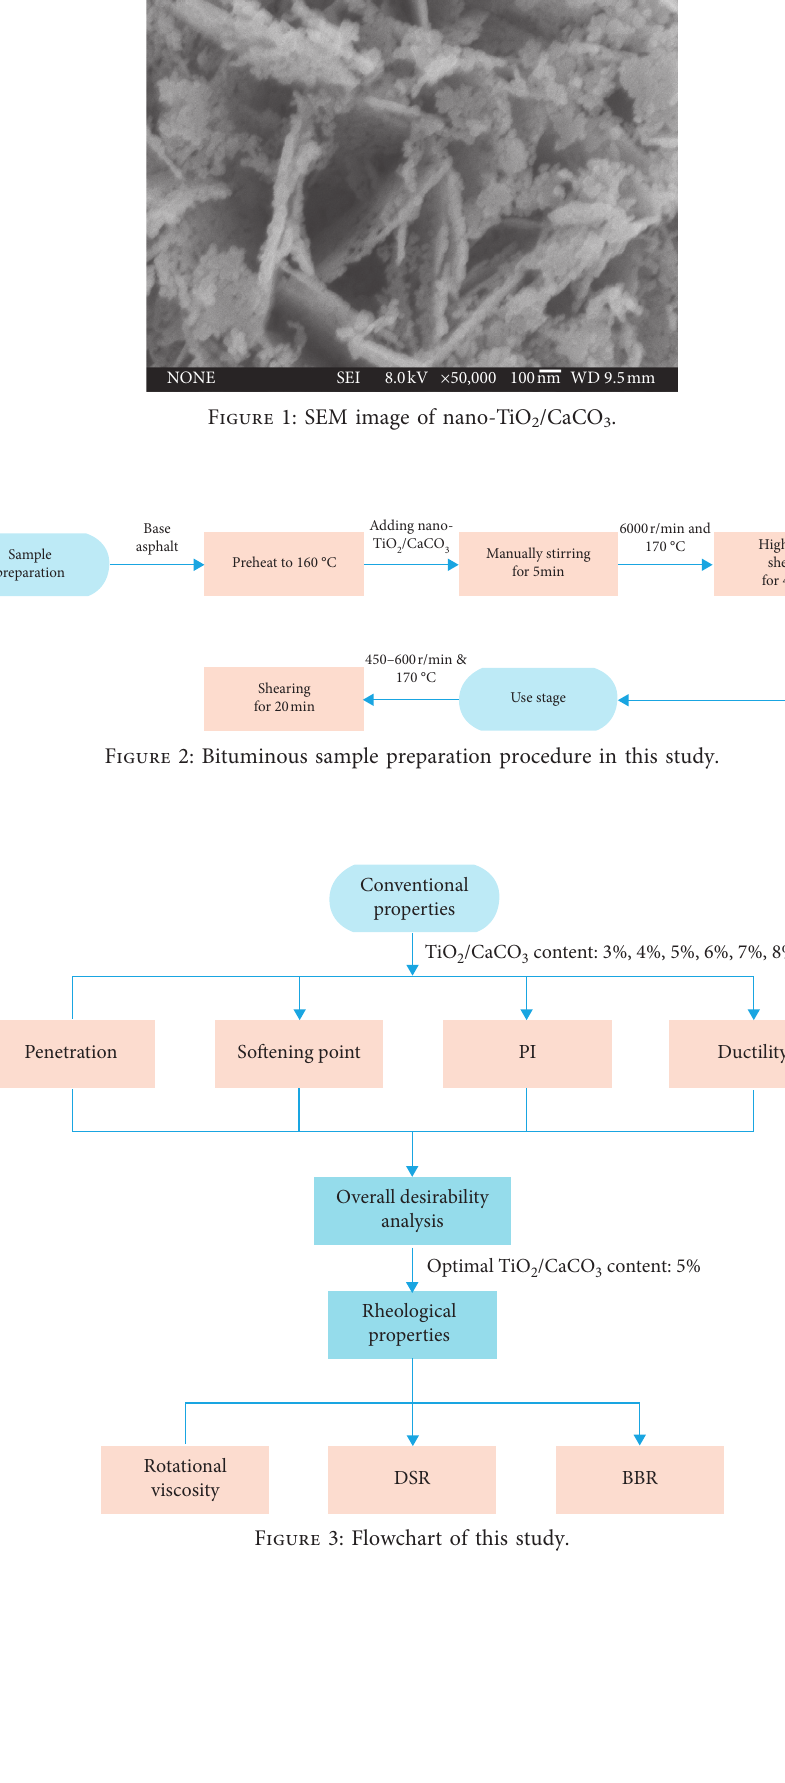
Figure 3: Flowchart of this